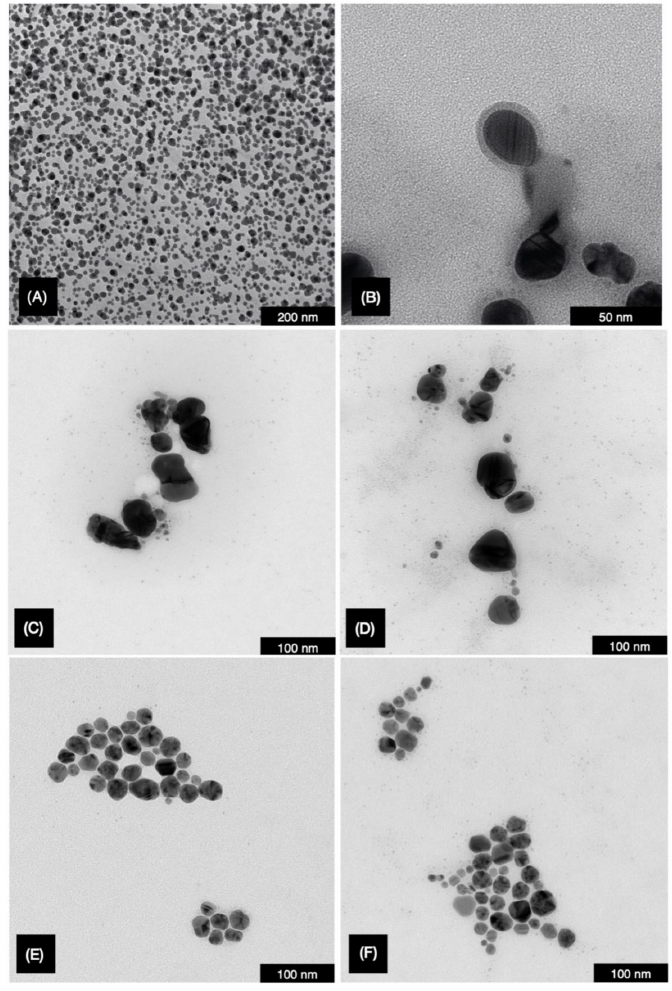
Figure 1. The TEM images of the different biogenic AgNPs synthesized and stabilized with Fusarium oxysporum proteins (AgNP-FU), ( A , B ), orange peel water extract (AgNP-OR), ( C , D ), and hesperidin and cellulose nanofibers (AgNP Hsp-CNF), ( E , F ) (images were adapted from the literature